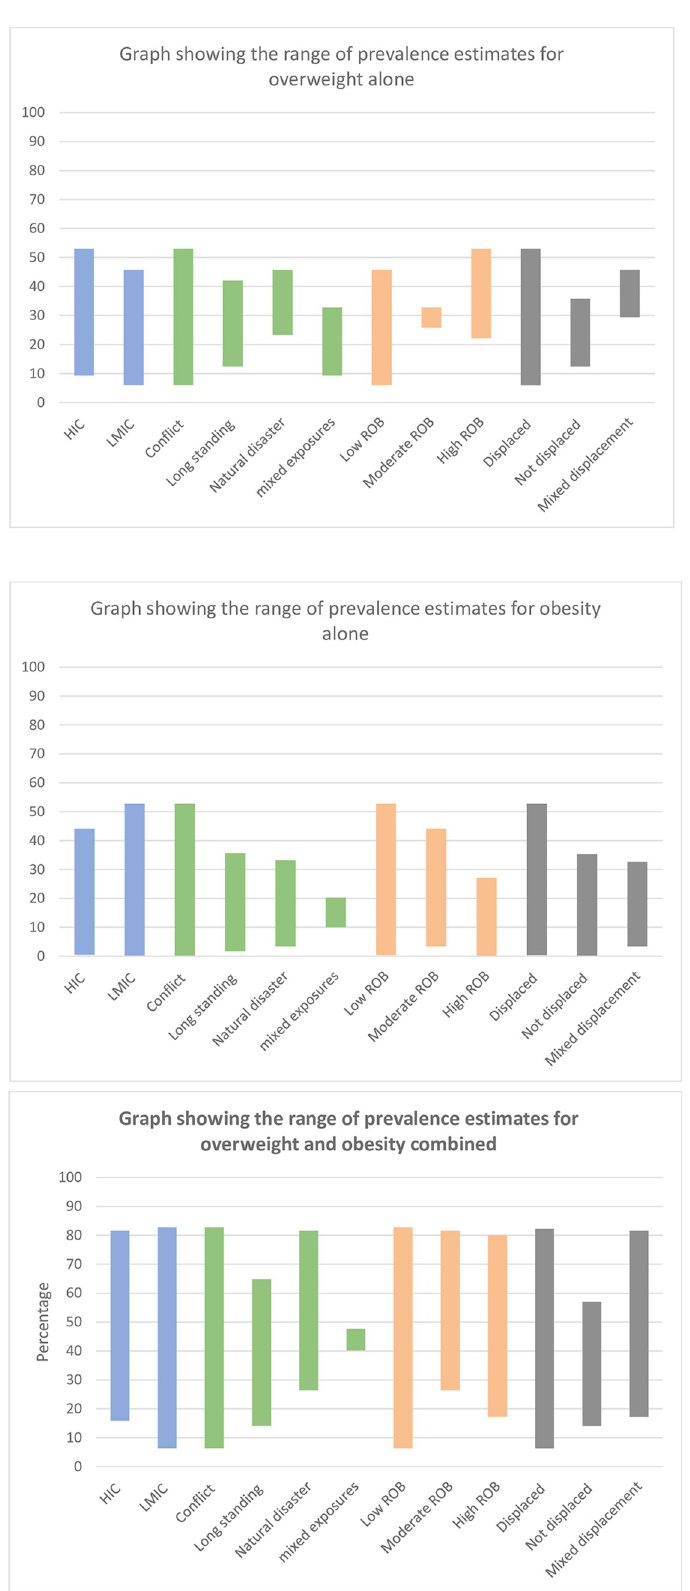
Fig 3. Showing the range of prevalence estimates in subgroups of interest for overweight, obesity and the two combined.